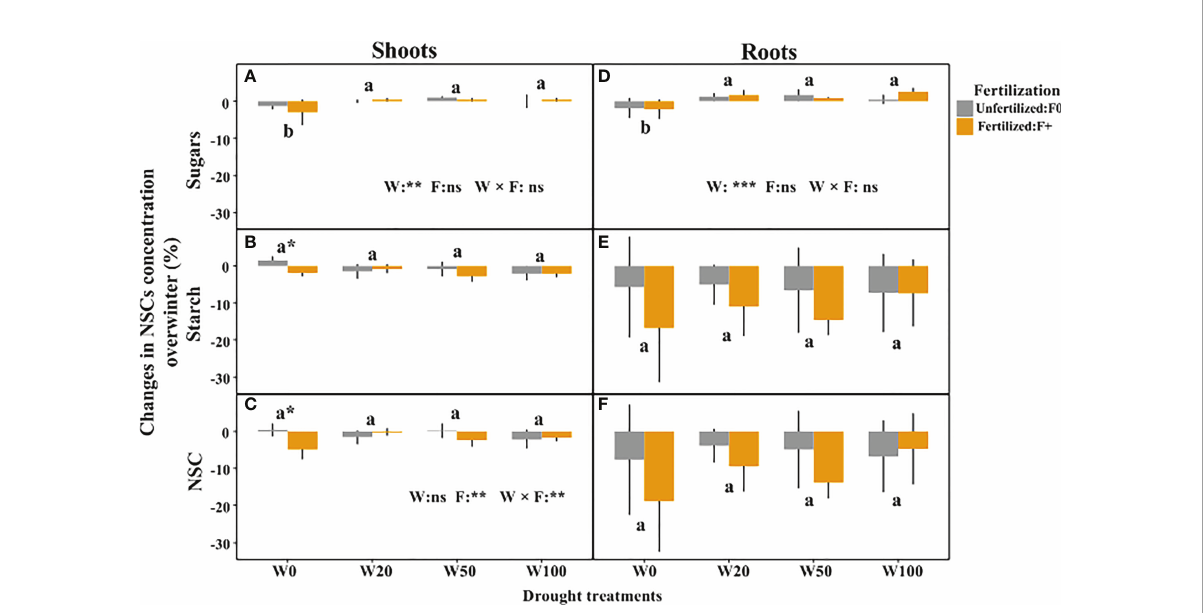
FIGURE 3 ChangesinNSCconcentrationsoverwinterinshootsandrootsofdownyoakswithdifferentdroughtandfertilizationtreatments. (A) sugarschangesinshoots, (B) starchchangesinshoots, (C) thetotalNSC(sugars+starch)changesinshoots; (D) sugarschangesinroots, (E) starchchangesinroots, (F) thetotalNSC (sugars+starch)changesinroots.ThedroughttreatmentscontainW100,W50,W20,andW0,represents100%,50%,20%,and0%ofsoilmoistureatthe fi eld watercapacity,respectively.Differentlowercaseslettersrepresentsigni fi cantdifferencesinmeansamongdroughttreatmentstestedbyTukeyHSD,*signs showsigni fi cantdifferencebetweenunfertilized(F0)andfertilized(F+)treeswithinthewatertreatment.ErrorbarsindicatetheSDofthemeanvalues( n =4).